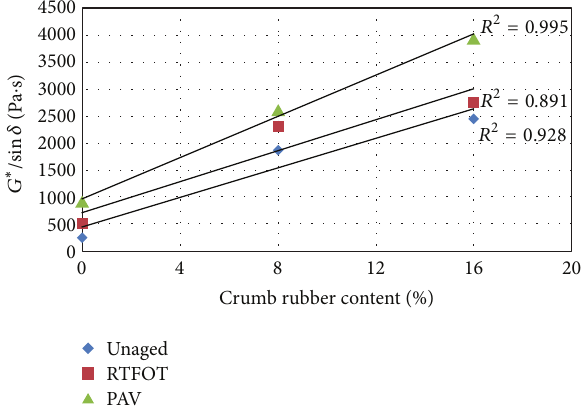
Figure 4: Effect of aging on penetration of bitumen binder.